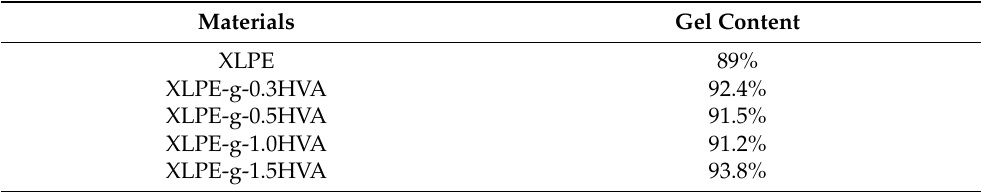
Table 1. Gel contents of XLPE and HVA-2 grafted XLPE.